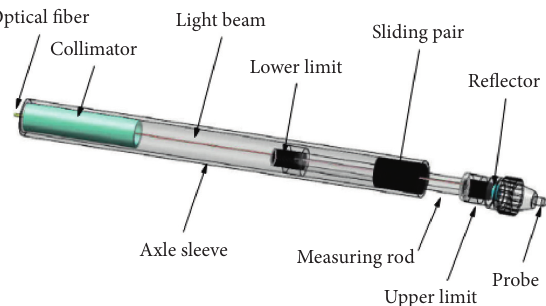
Figure 10: CAD of contact laser interference displacement sensor.